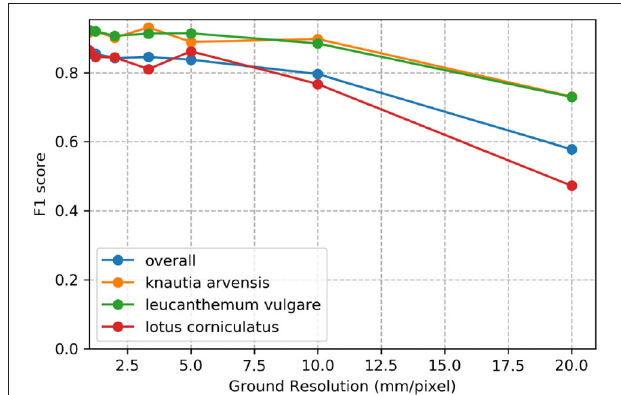
FIGURE 8 | Evolution of the F1 score over various simulated ground resolutions.